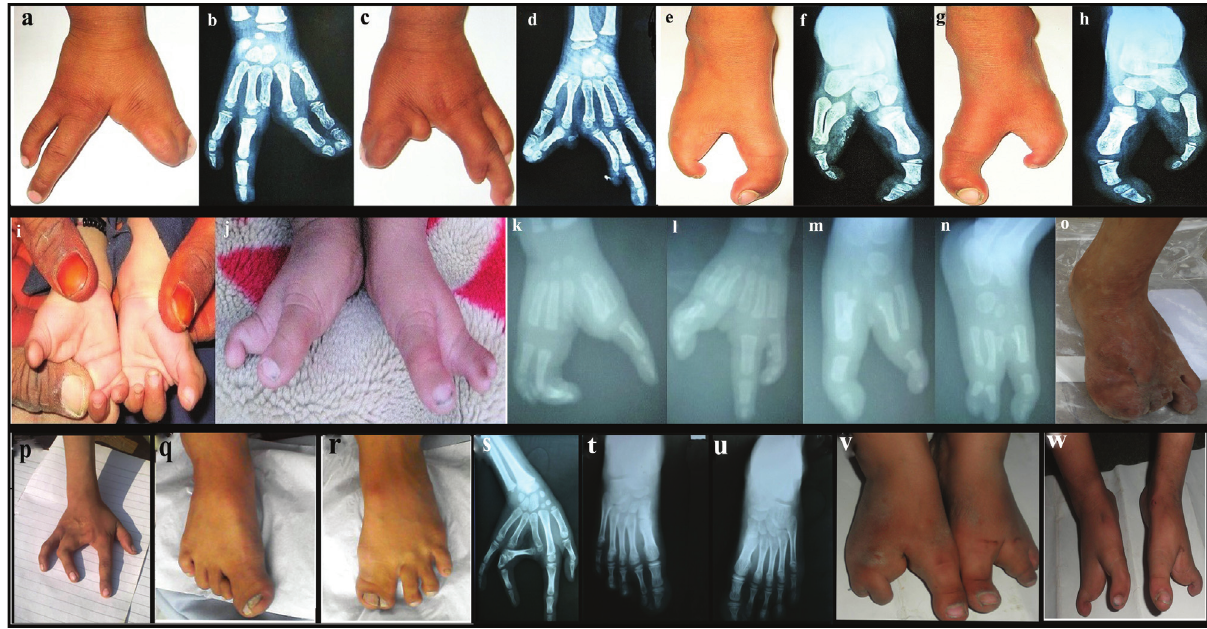
Figure 2 - Clinical features of split hand/foot malformation (SHFM) observed in family A. (a) Female patient (IV-1) showing cleft hand deformity with absenceofmiddlefingerinrighthand,andsyndactylyof1 st and2 nd finger.(b)Radiographshowingpre-axialsyndactylyofindexfingerandthumbatdis- tal phalanx as well as in 3 rd and 4 th metacarpals. (c, d) The same patient (IV-1) showing cleft hand deformity with central type syndactyly in her left hand, andwithanadditionalbudonthe2 nd metacarpal;distalphalanxinthemiddlefingerismissing.(e,h)Classicalcleftfeetdeformitiescharacterizedbycen- tral deficiency in the same affected individual, radiographs showing hallux valgus deformities in the big toe, missing central toes and presence of postaxial syndactyly in the metatarsal bones; some of the tarsal bones are missing. (i, j) Male affected individual (IV-2) showing cleft hand deformity as- sociated with missing of 2 nd and 3 rd finger. (k, n) The same affected member showing cleft feet deformity; radiological study showing bilateral cleft hand/feet deformities associated with preaxial and postaxial syndactyly in the hands and feet, respectively. (o) Clinical features of an affected girl (IV-1) in family B showing missing big toe along with 2 nd and 3 rd toes. (p) An affected individual (IV-2) in family C showing absence of middle phalanx of 3 rd finger in right hand, severe bilateral hypoplasia and fusion of the 3 rd and 4 th finger. (q, r) The same patient, showing pre-axial syndactyly in toes 1 and 2 in both feet, and an additional bud on the 3 rd toe in right foot. (s) Radiographic features of the right hand of the patient (IV-2) showing radial ray malforma- tionincludinghypoplasiaof1 st metacarpal,complexfusionofmiddlefingertoringfinger,relativelylargeproximalphalanxof5 th finger,fingersshowing contractures and deviations. (t-u) Radiographs of the feet showing fusion of the 1 st and 2 nd toes. (v) Affected individual (IV-3) in family C showing bilat- eralcleftfootwithmissing2 nd and3 rd digits,centraldeficiencywithrudimentarybudoflessertoe,classicalcleftfoot,andbasalsyndactylyformation.(w) Affected individual (V-1) in family D showing cleft foot deformity, i.e. longitudinal deficiency of digital ray of the foot except rays 1 or 5, central defi- ciency and varus deformity of lesser toe, claw toe deformity, classical cleft foot and fusion of the middle and distal phalanx of 5 th